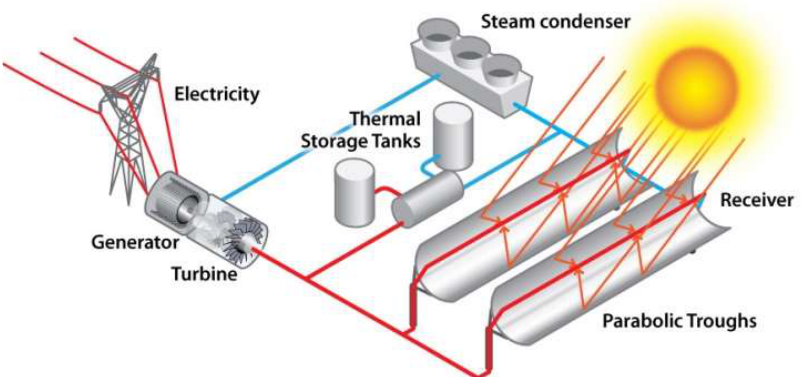
Figure 1 . Parabolic trough power station. Source: Office of Energy Efficiency and Renewable Energy [25]. (i) The technology contains parabolic trough mirror solar collectors. (ii) Pipes at the focal point of the parabolic mirrors are filled with heat transfer fluid. (iii) Heated fluid is used to drive steam turbine generators. (iv) Fluid can be stored to generate power when the sun is not visible.